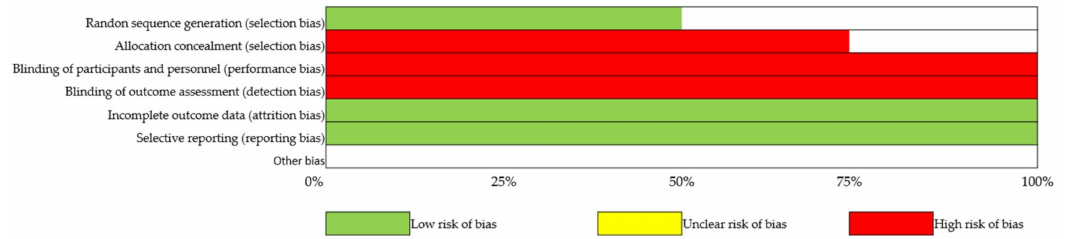
Figure 3. Risk of bias summary for all included